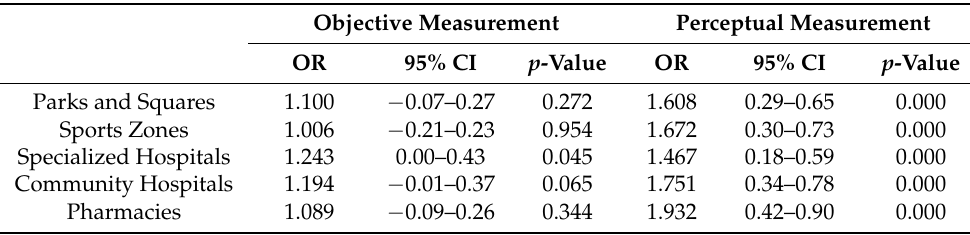
Table 10. Ordered logistic regression analysis of objectively measured and perceived measurement accessibility and accessibility satisfaction of health service